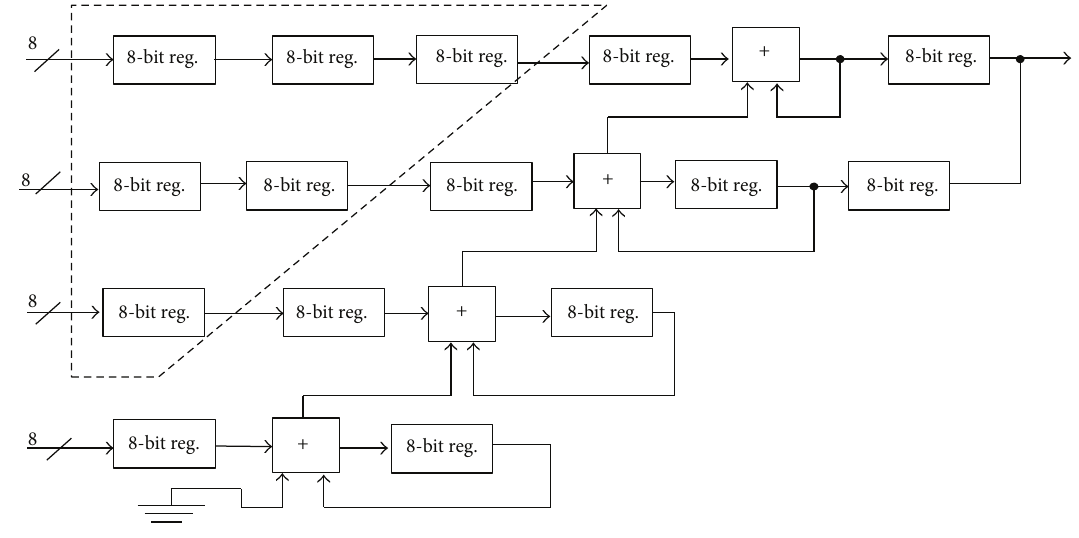
Figure 1: The conventional 32-bit pipelining phase